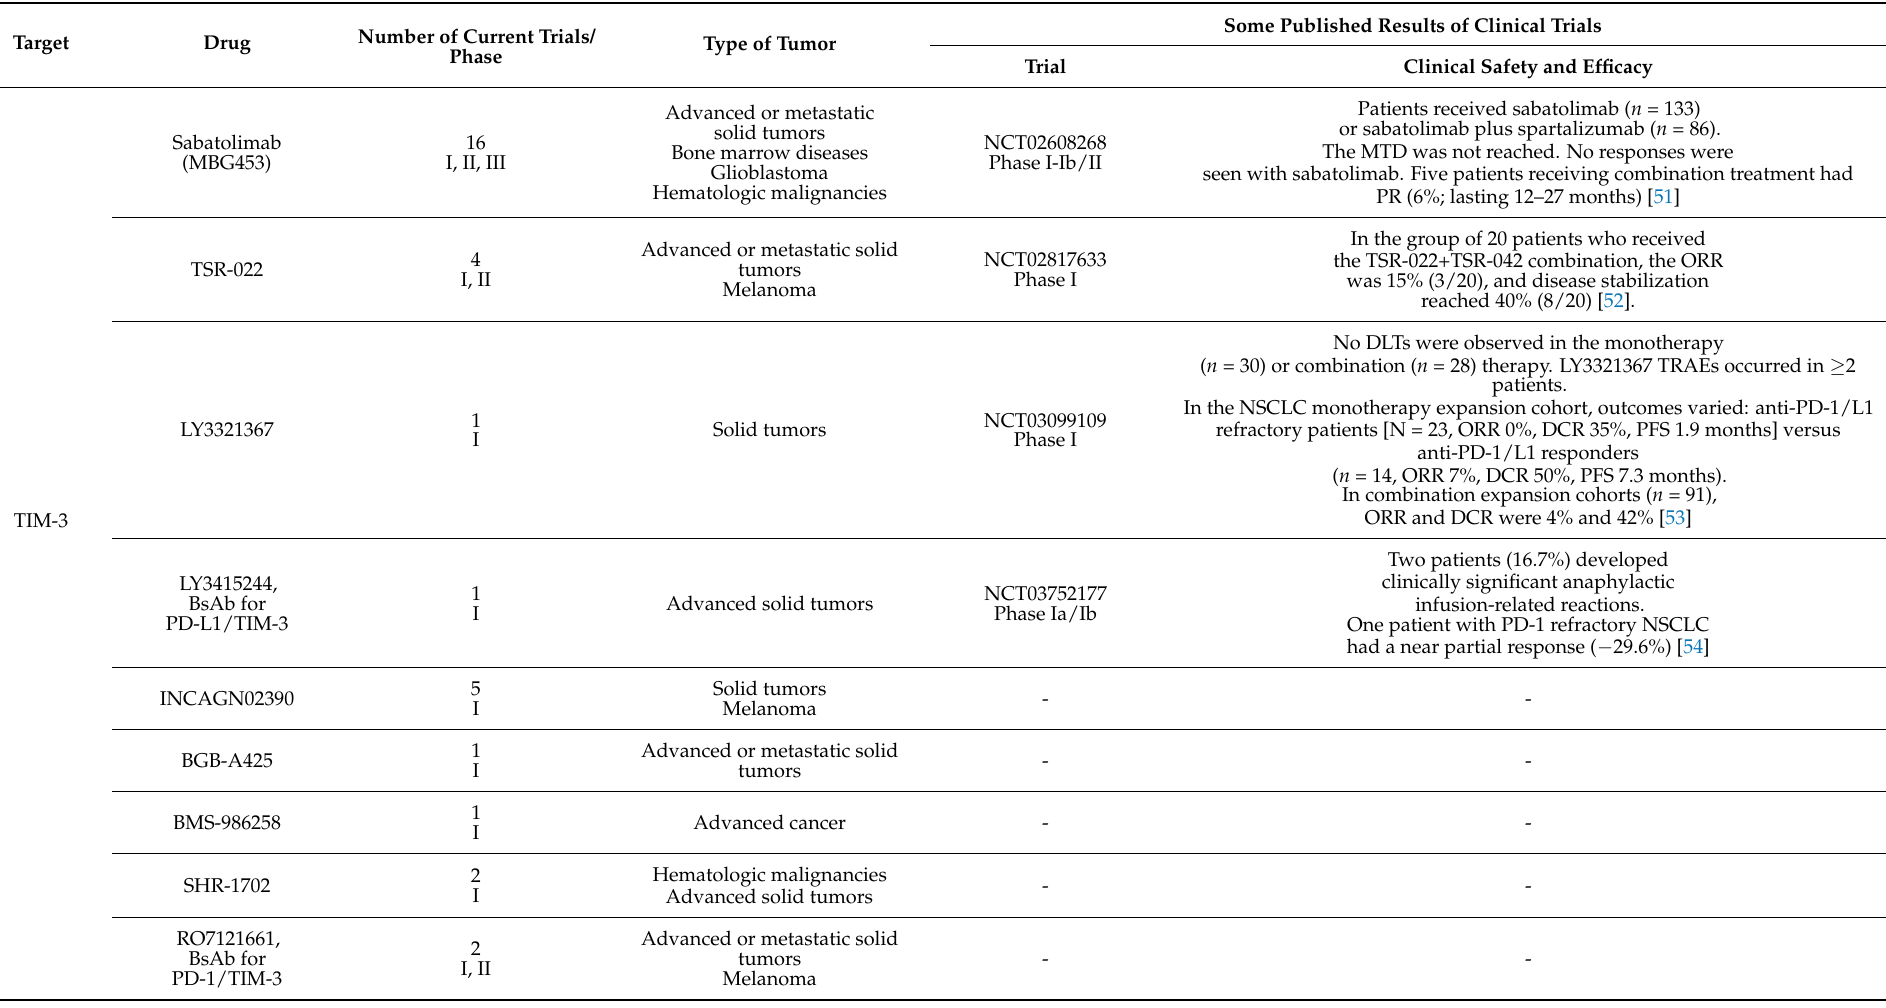
Table 2. Summary of ongoing clinical trials of receptor